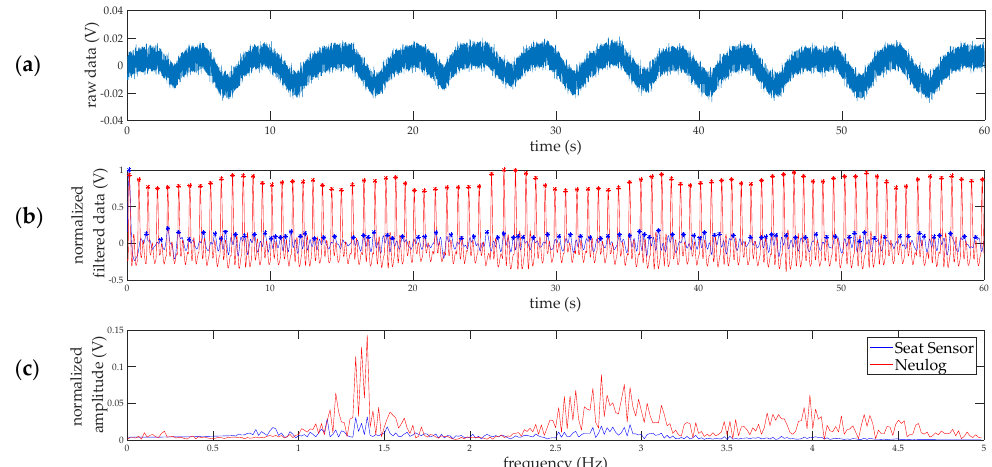
Figure 3. Sample heart rate data processing and measurements for 1-min of data collection at 100 Hz. ( a ) Raw voltage output from the seat sensor; ( b ) the filtered pulse signal is shown in blue and the analog benchmark data from the Neulog pulse monitor is shown in red. The signals are normalized and each peak, indicated by the stars, represents one breath; ( c ) the power spectrum for the seat sensor and benchmark data, showing the FFT frequency components composing the normalized signals.